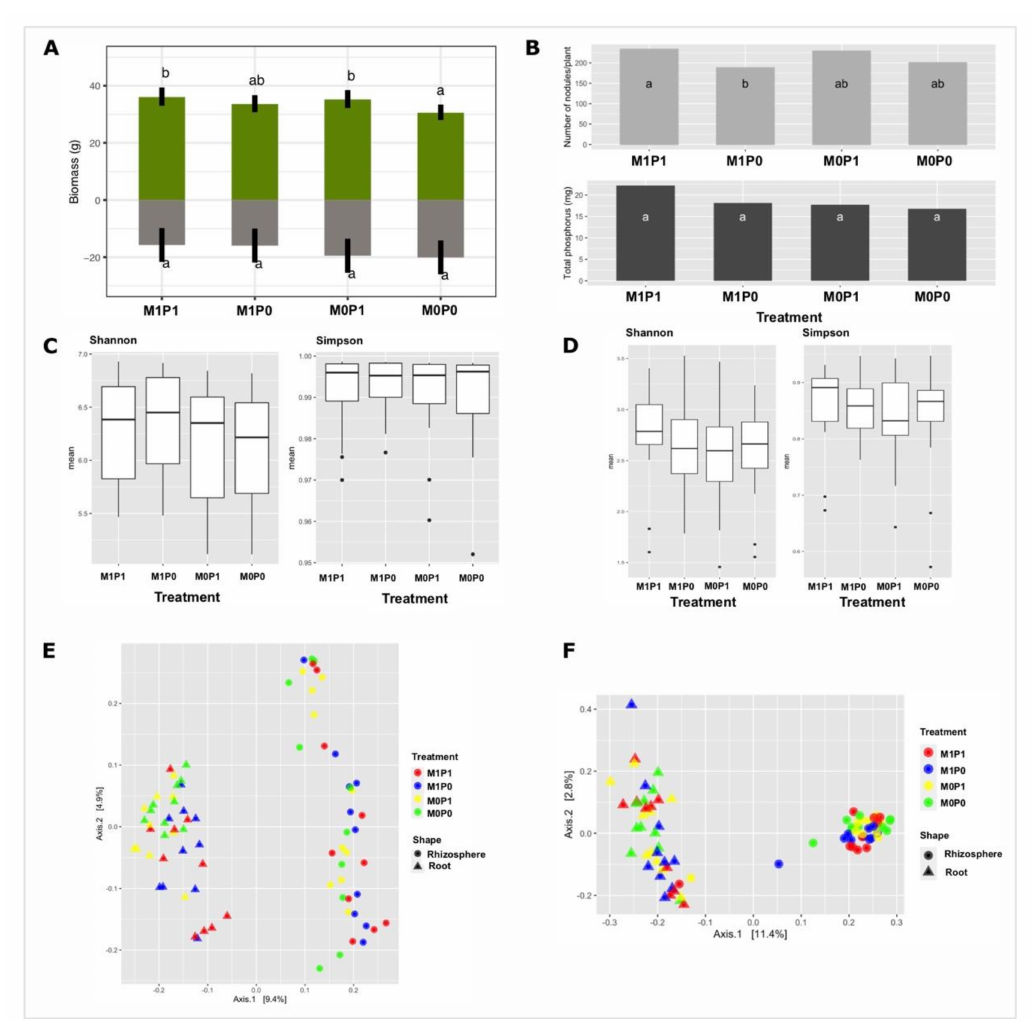
Figure 1. Measures of plant biomass, nodulation and total phosphorus, and microbial community structure. ( A ) Dry weight (g) of shoot and root. Green boxplots represent shoot dry weight, and grey boxplots represent root dry weight; ( B ) number of nodules per plant and total phosphorus measured in shoots. With each treatment group, means with the same letter are not significantly different by a Tukey’s range test. M 1 P 1 = presence of both microbial inoculum and phytate; M 1 P 0 = only microbial inoculum; M 0 P 1 = only phytate, and M 0 P 0 = absence of both microbial inoculum and phytate. ( C ) Shannon and Simpson diversity for bacterial microbiota; ( D ) Shannon and Simpson diversity for fungal microbiota. M 1 P 1 = presence of both microbial inoculum and phytate; M 1 P 0 = only microbial inoculum; M 0 P 1 = only phytate, and M 0 P 0 = absence of both microbial inoculum and phytate. Principal coordinates analysis (PCoA) showing the community compositions assignments of ( E ) bacterial 16S r RNA genes and ( F ) fungal ITS genes data. The variation shown in axes 1 and 2 of the ordinations is indicated in parenthesis. Circular and triangle shape represents samples from rhizosphere soil and root, respectively. Each colour represents a sample. M 1 P 1 = microbial inocula and phytate; M 1 P 0 = only microbial inocula; M 0 P 1 = phytate only and M 0 P 0 = absence of both microbial inocula and